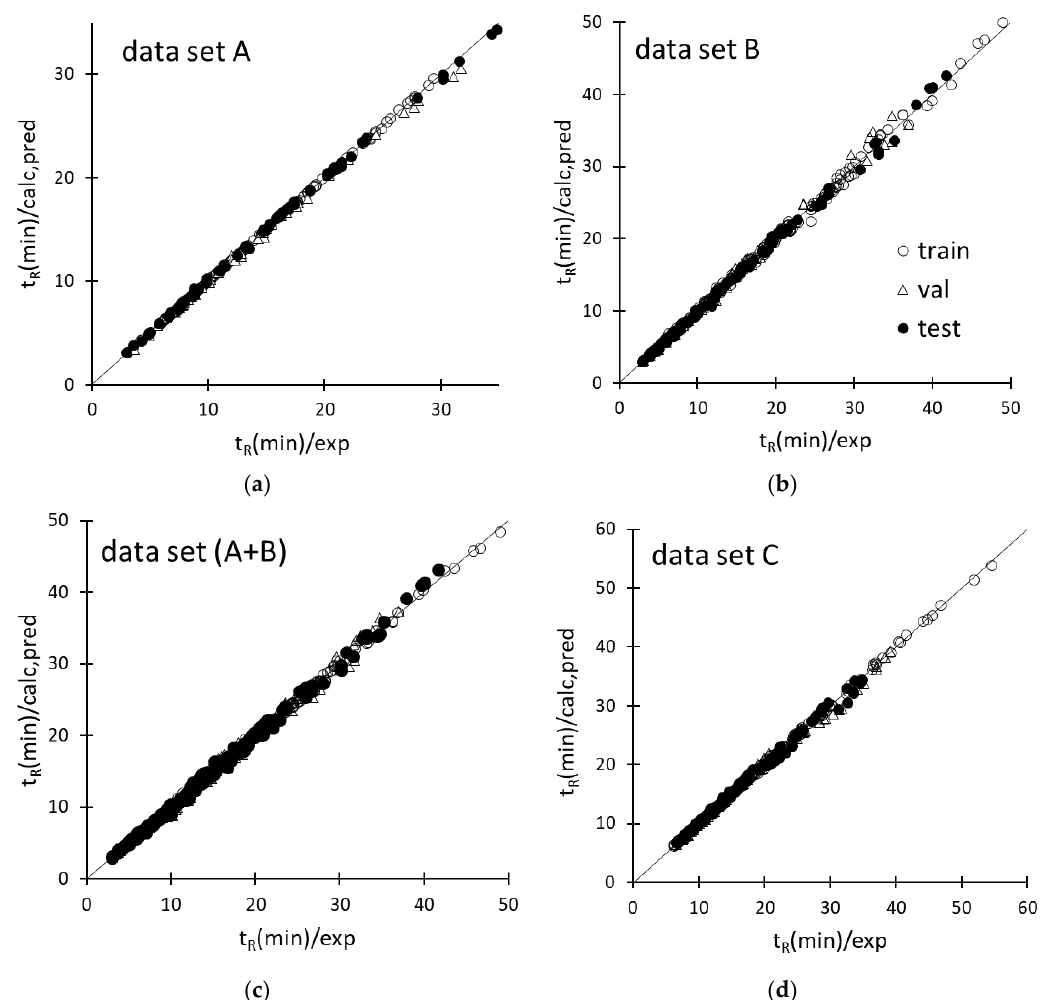
Figure 2. Agreement between the experimental retention times (t R (min)/exp) of solutes and calculated or predicted ANN responses (t R (min)/calc,pred) of datasets A ( a ), B ( b ), A+B ( c ), and D ( d ).